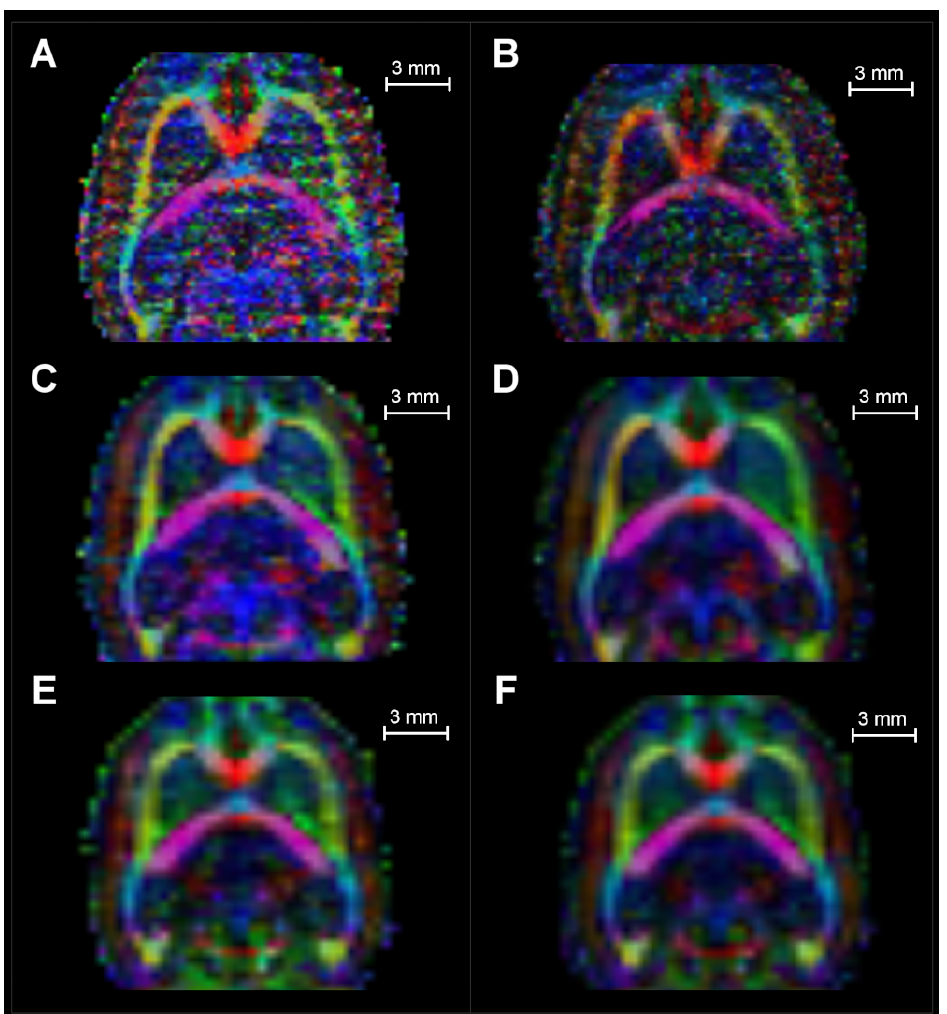
Figure 7: Axial view of one slice. Rows from top to bottom: resolutions of 0 . 2 mm 3 , 0 . 3 mm 3 and 0 . 4 mm 3 . Left column (A, C, E): MoD images. Right col (B, D, and F): Tensor domain averaged images